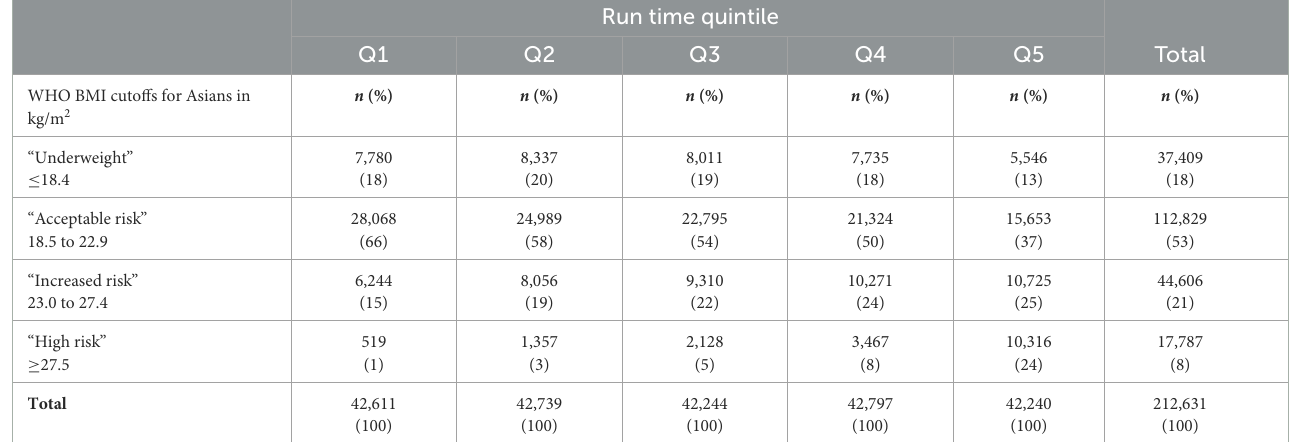
TABLE 2 Frequency counts and column percentages for run-time quintiles and BMI category at baseline ( n =